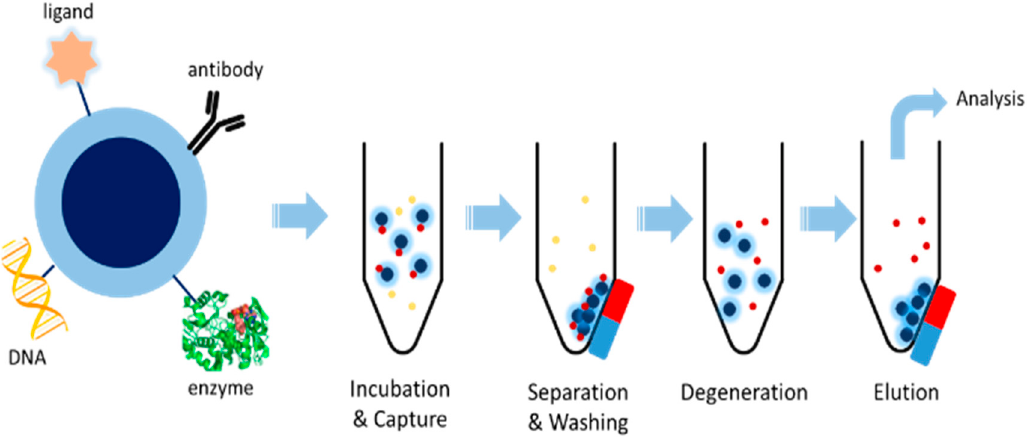
Figure 2. Scheme of magnetic beads based ligand fishing.